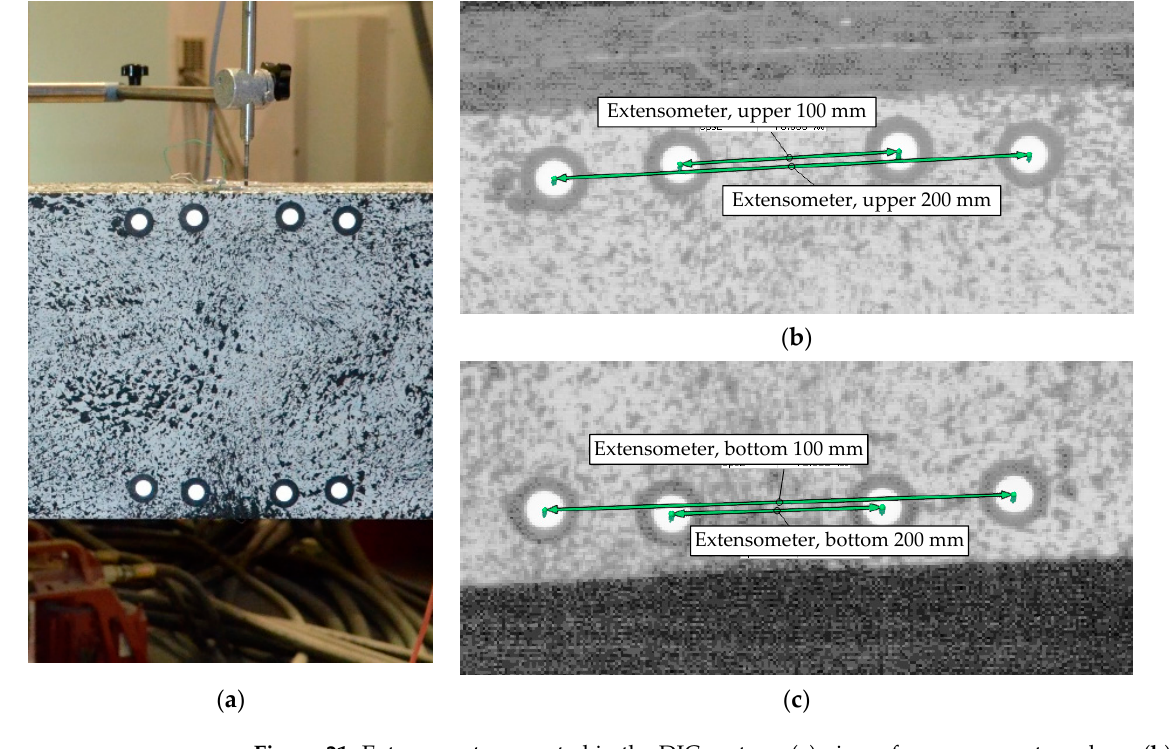
Figure 21. Extensometers created in the DIC system: ( a ) view of measurement markers; ( b ) exten- someters at the top of the section; ( c ) extensometers at the bottom of the section. First, measurements in the elastic range were made, with vertical displacement in